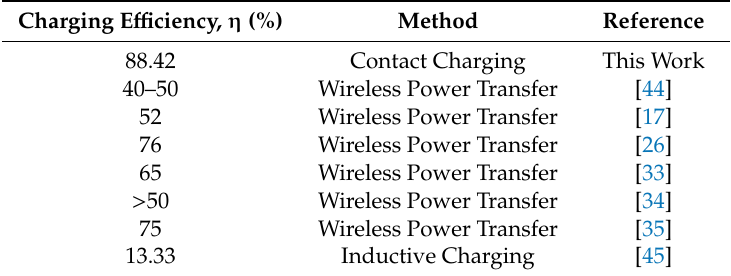
Table 2. Comparison table for charging e ffi